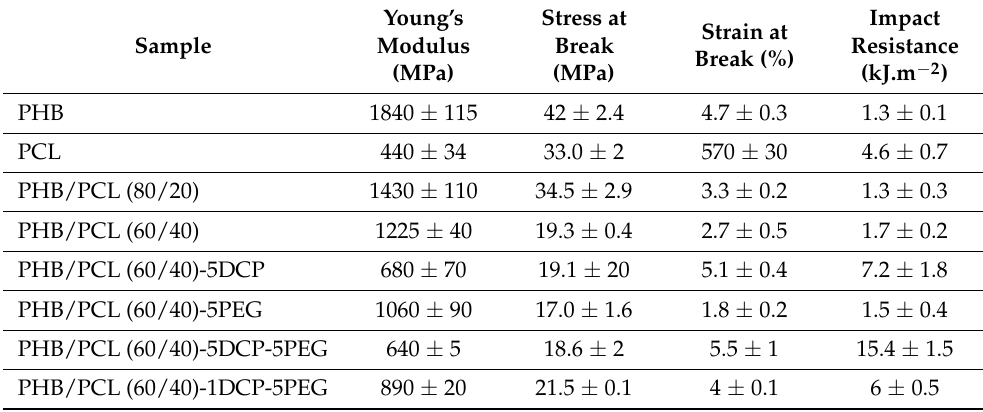
Table 2. Tensile results of PHB/PCL materials containing DCP and